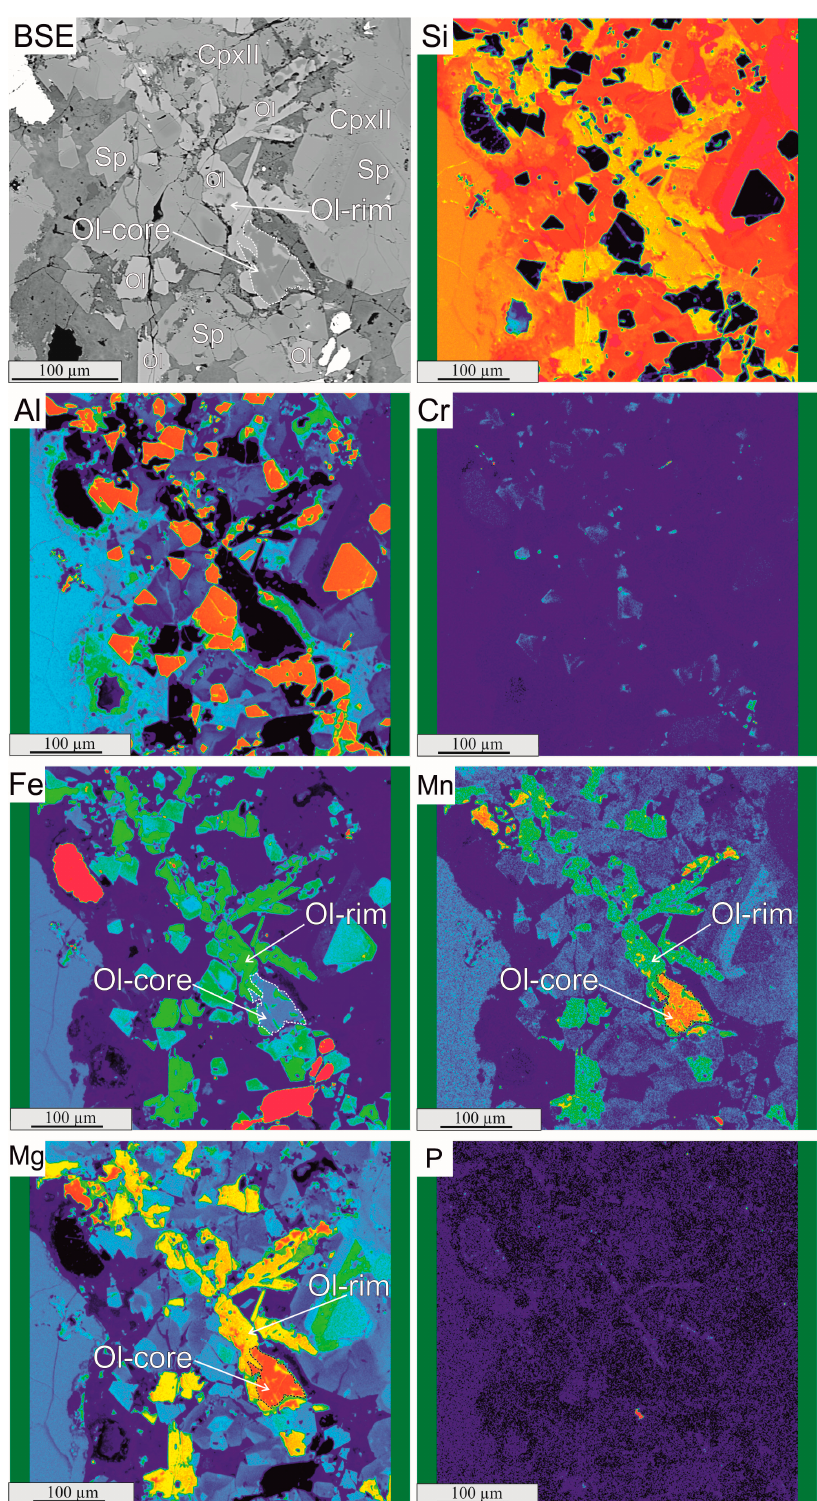
Figure 6. Back-scattered electron (BSE) image and elemental maps of Si, Al, Cr, Fe, Mn, Mg and P in the olivine-bearing assemblage from Uv-537 eclogite. Sp—spinel; Ol—olivine; CpxII—diopside.